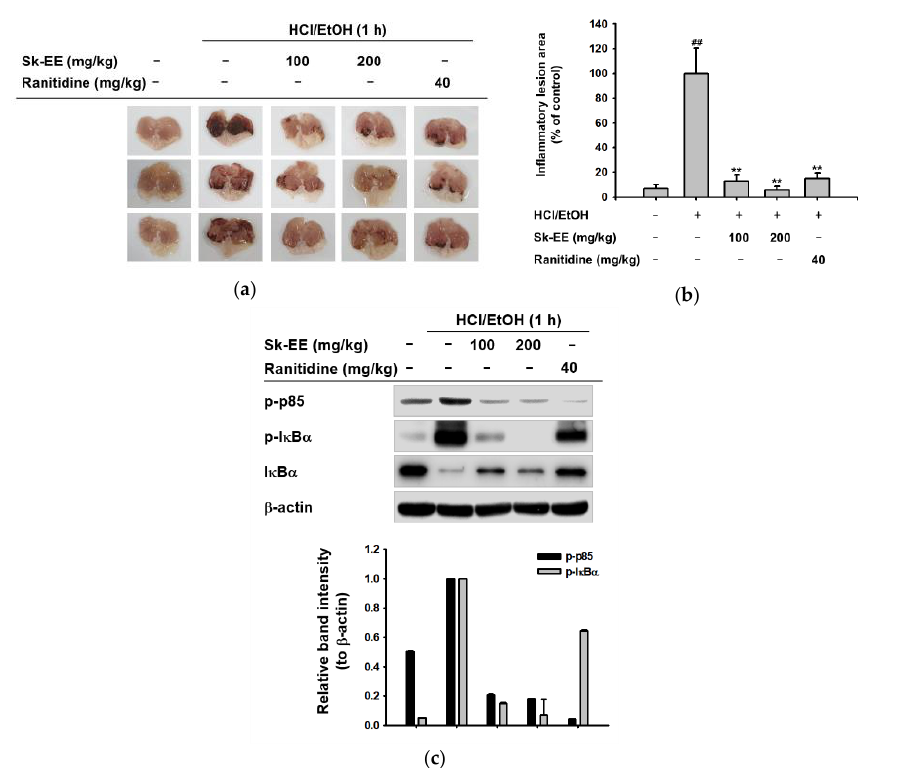
Figure 4. In vivo e ff ects of Sk-EE on HCl / EtOH-induced gastritis mice. ( a ) The indicated doses of Sk-EE and control compound ranitidine were orally injected into mice three times in two days. HCl / EtOH was orally administered to mice one hour before sacrifice. The stomachs of sacrificed mice were isolated and inflammatory lesions were photographed. ( b ) Inflammatory lesion areas of each group were numerically analyzed by ImageJ (National Institutes of Health, Bethesda, MD, USA) and graphed. ( c ) The stomach samples of the gastritis mouse model were ground and lysed with bu ff er. Protein levels of total and phosphorylated forms of I κ B α and control protein β -actin were analyzed by western blotting. # p < 0.05 and ## p < 0.01 compared to normal group; * p < 0.05 and ** p < 0.01 compared to control group. Data presented ( b ) are expressed as mean ± SD of experiments performed with 3 samples. + : treatment, − : no